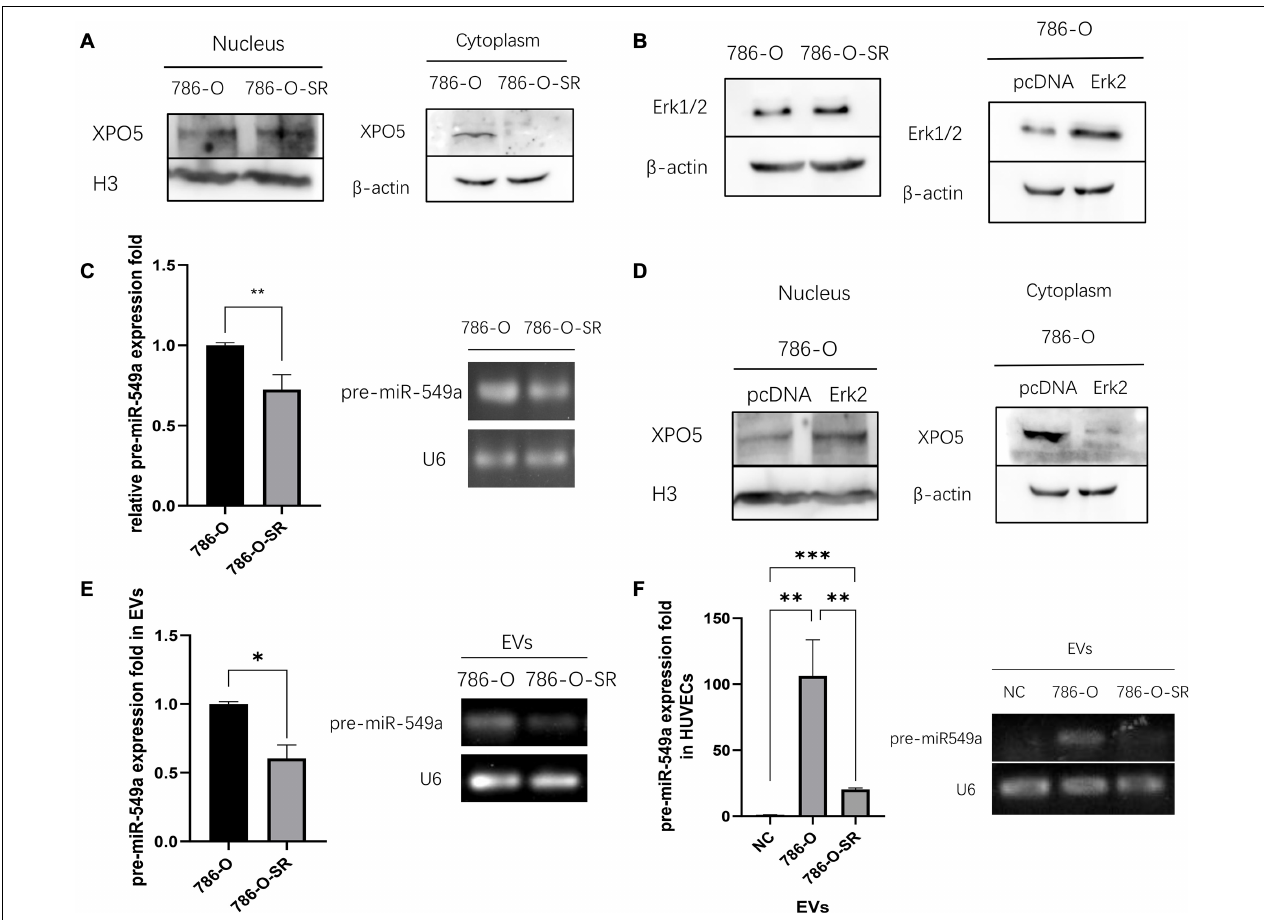
FIGURE 7 | Erk2 regulates the output of miR-549a via XPO5. (A) Cytosolic and nuclear protein were prepared and analyzed for XPO5 expression in 786-O and 786-O-SR by Western blot. (B) Western blot analysis of Erk1/2 expression in 786-O and 786-O-SR and the detection of overexpression efficiency of Erk2 in 786-O. (C) RT-PCR and gel electrophoresis of PCR products analysis of pre-miR-549a expression in 786-O/786-O-SR cells. (D) Cytosolic and nuclear XPO5 expression in 786-O and Erk2 overexpressing 786-O by Western blotting. (E,F) RT-PCR and gel electrophoresis of PCR products analysis of pre-miR-549a expression in 786-O/786-O-SR exosomes (E) and HUVECs treated with exosomes (F) . ∗ P < 0.05, ∗∗ P < 0.01, ∗∗∗ P < 0.001 according to two-tailed Student’s t